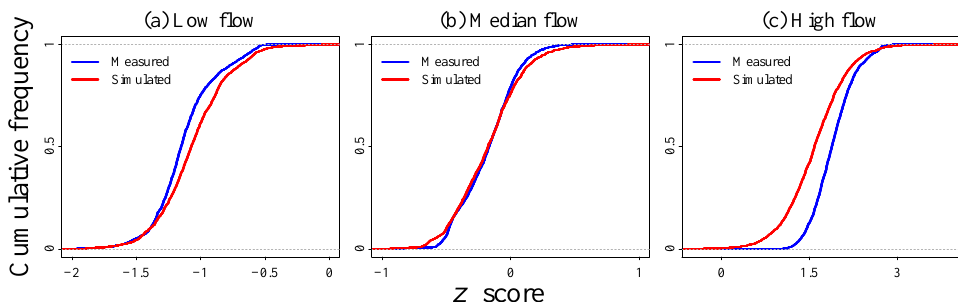
Figure 11. The z score cumulative frequency for (a) highest-, (b) median-, and (c) lowest-flow